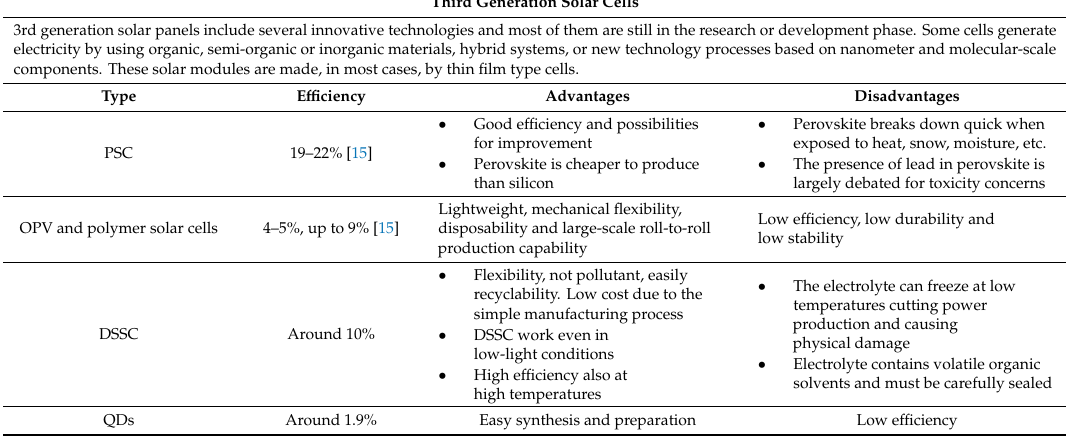
Table 3. Third generation PV